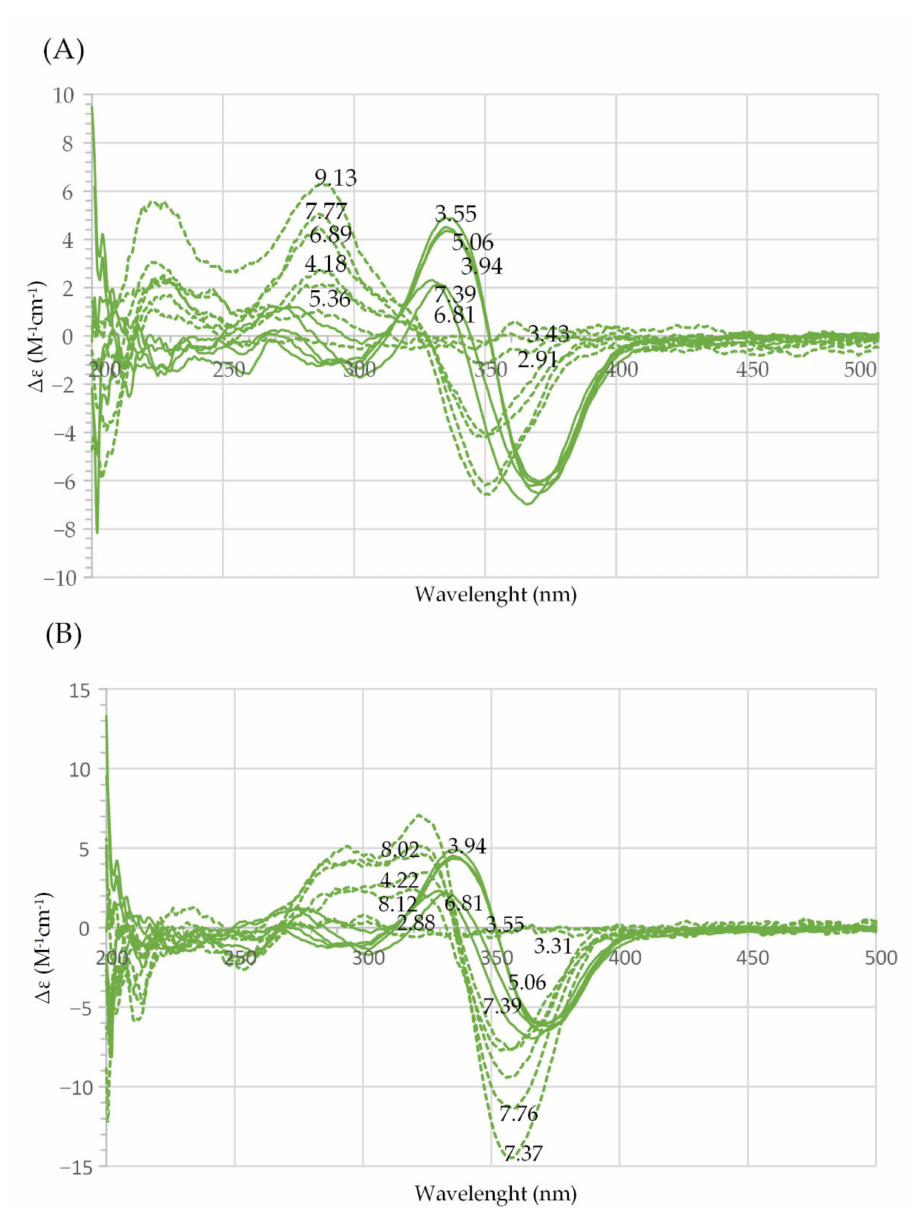
Figure 2. ( A ) Superimposition of far-UV circular dichroism (CD) spectra of harzianic acid ( ≤ 1.72 × 10 − 4 M, dashed curves) and of Gd 3+ –harzianic acid system at 1:1 ligand-to-metal ratio (continuous curves) in CH 3 OH/0.1 M NaClO 4 (50:50 w / w ) at different pH values; ( B ) uperim- position of far-UV circular dichroism (CD) spectra of Gd 3+ –harzianic acid system (full lines) and La 3+ –harzianic acid system (dashed lines) at 1:1 ligand-to-metal ratio in CH 3 OH/0.1 M NaClO 4 (50:50 w / w ) at different pH values: C Gd ≤ 6.44 × 10 − 5 M, C H / C Gd = 1.00; C La ≤ 3.82 × 10 − 5 M, 2 L C H / C La = 0.995. In ( A , B ), numerical labels on curves indicate the corresponding 2 L